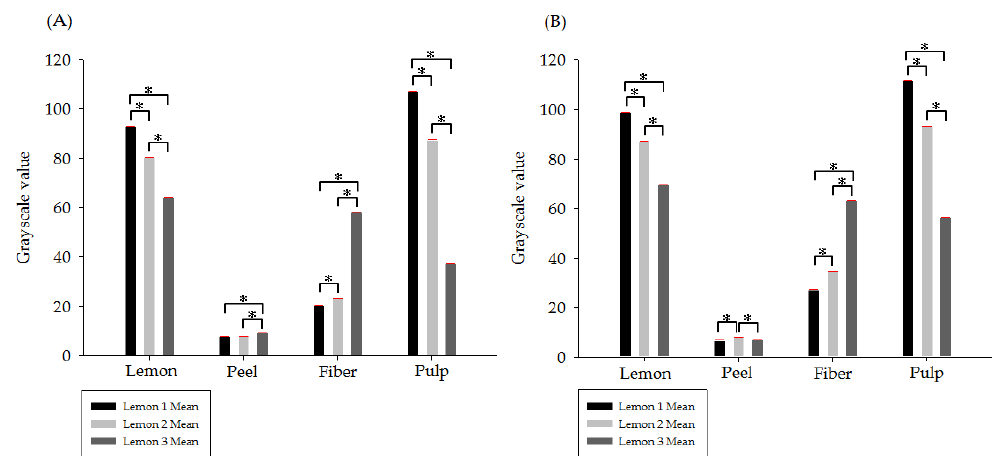
Figure 5. ( A , B ) represent two different phases. The images show the quantified statistical analysis results of (1) fresh, (2) mature, and (3) overripe lemons based on the four-layer stratification of lemon, peel, fiber, and pulp. The p values less than 0.05 are summarized with one asterisk.